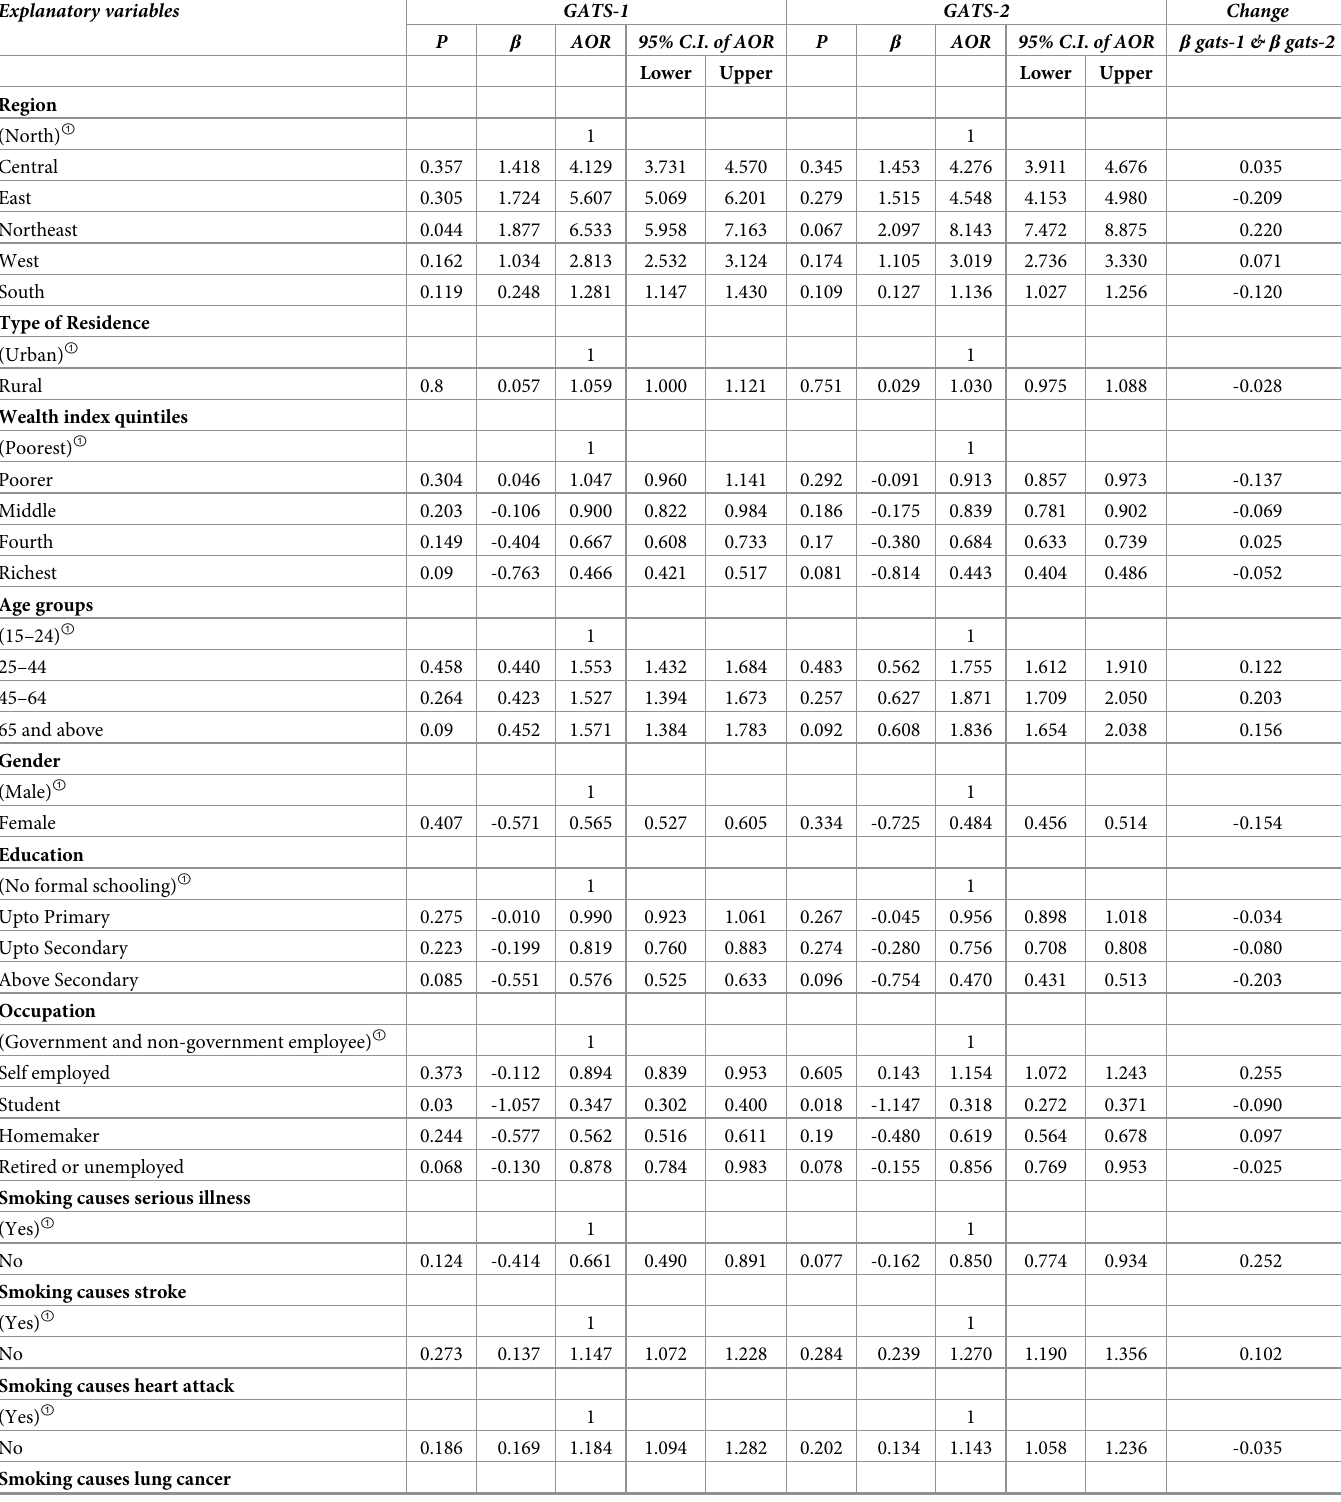
Table 3. Multivariable binary logistic regression for smokeless tobacco use in India, GATS-2009-10 and GATS-2016-17. Explanatory